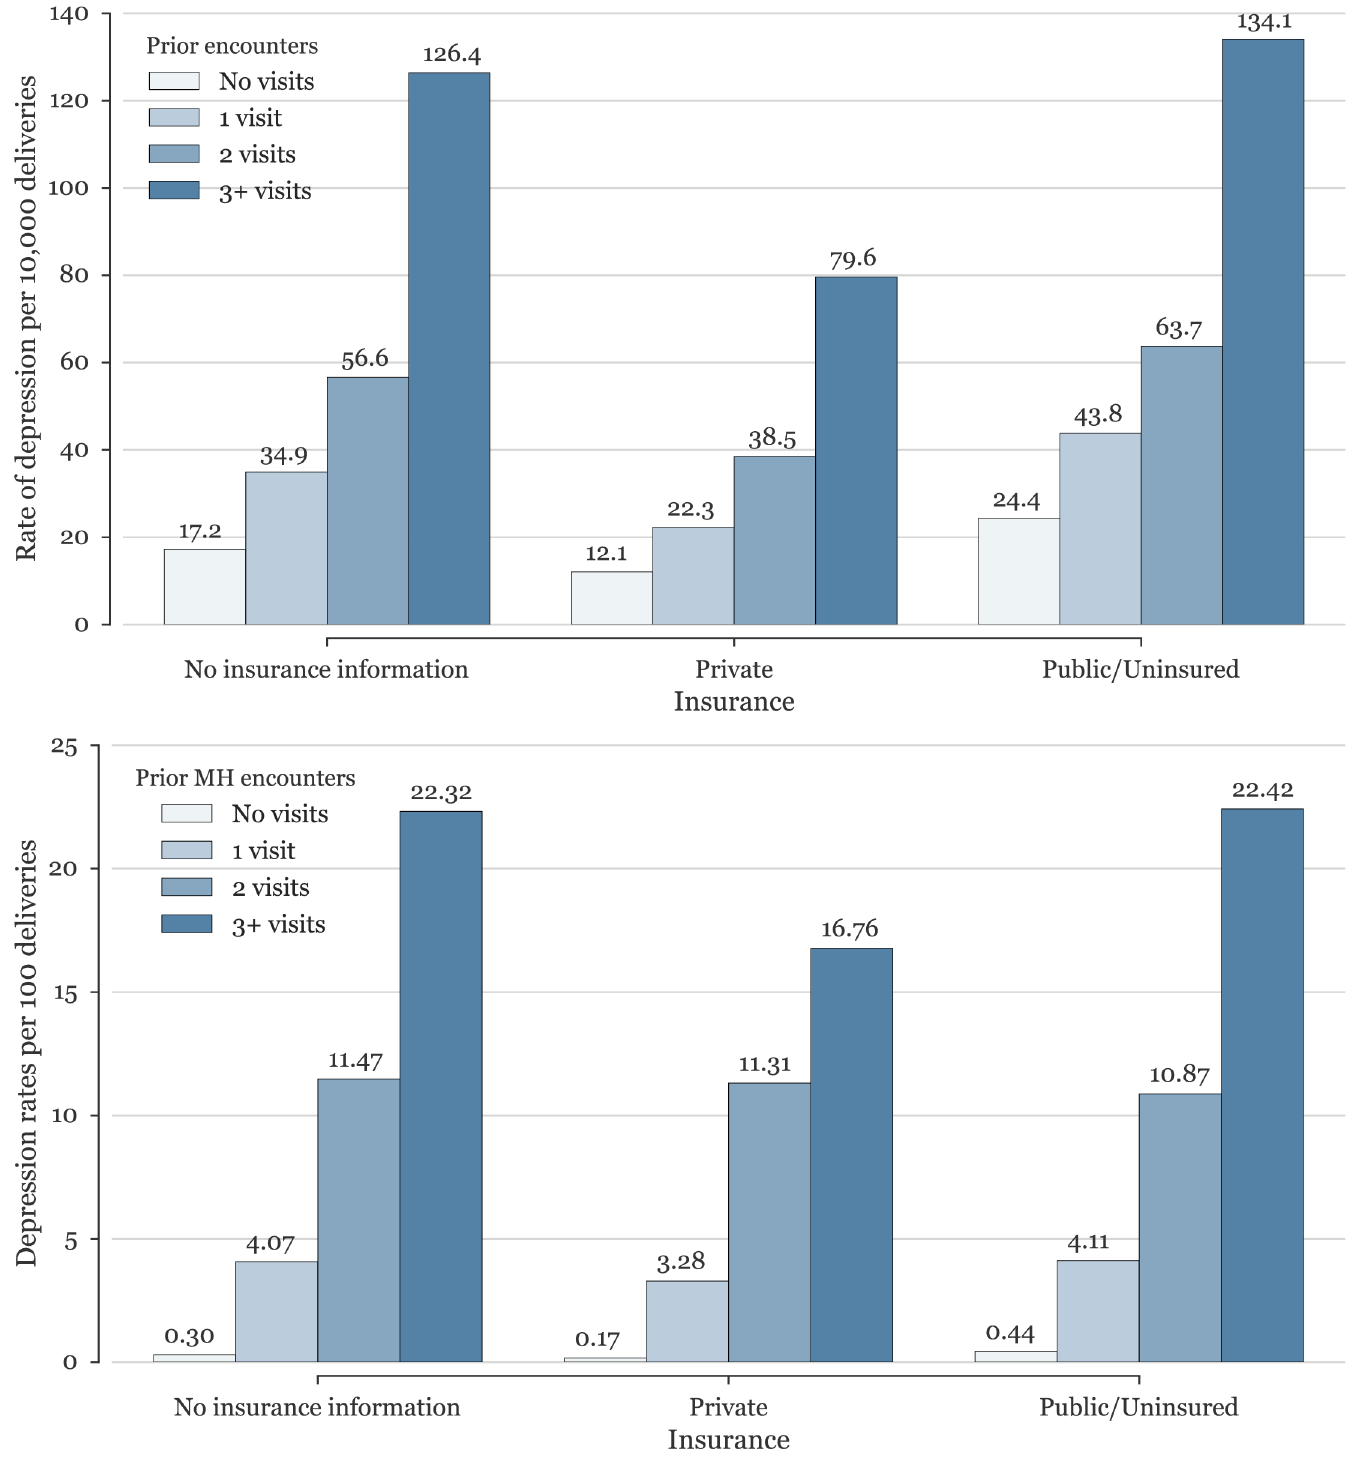
Fig 4. (Top panel) Rates of postpartum depression among women with differing insurance status as influenced by the number of prenatal hospital encounters. (Bottom panel) Rates of postpartum depression among women of differing insurance status as influenced by number of prenatal hospital encounters for mental health conditions . Note scale change: top rates are per 10,000 deliveries, bottom rates are per 100